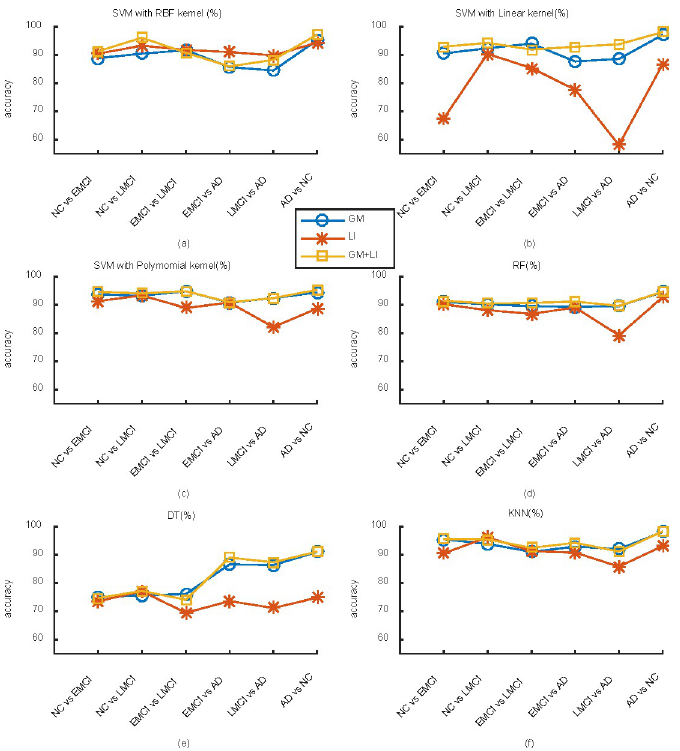
Fig 2. For each classification algorithm, the classification accuracies for binary subject groups NC versus EMCI, NC versus LEMC, EMCI versus LEMC, EMCI versus AD, LMCI versus AD, AD versus NC.